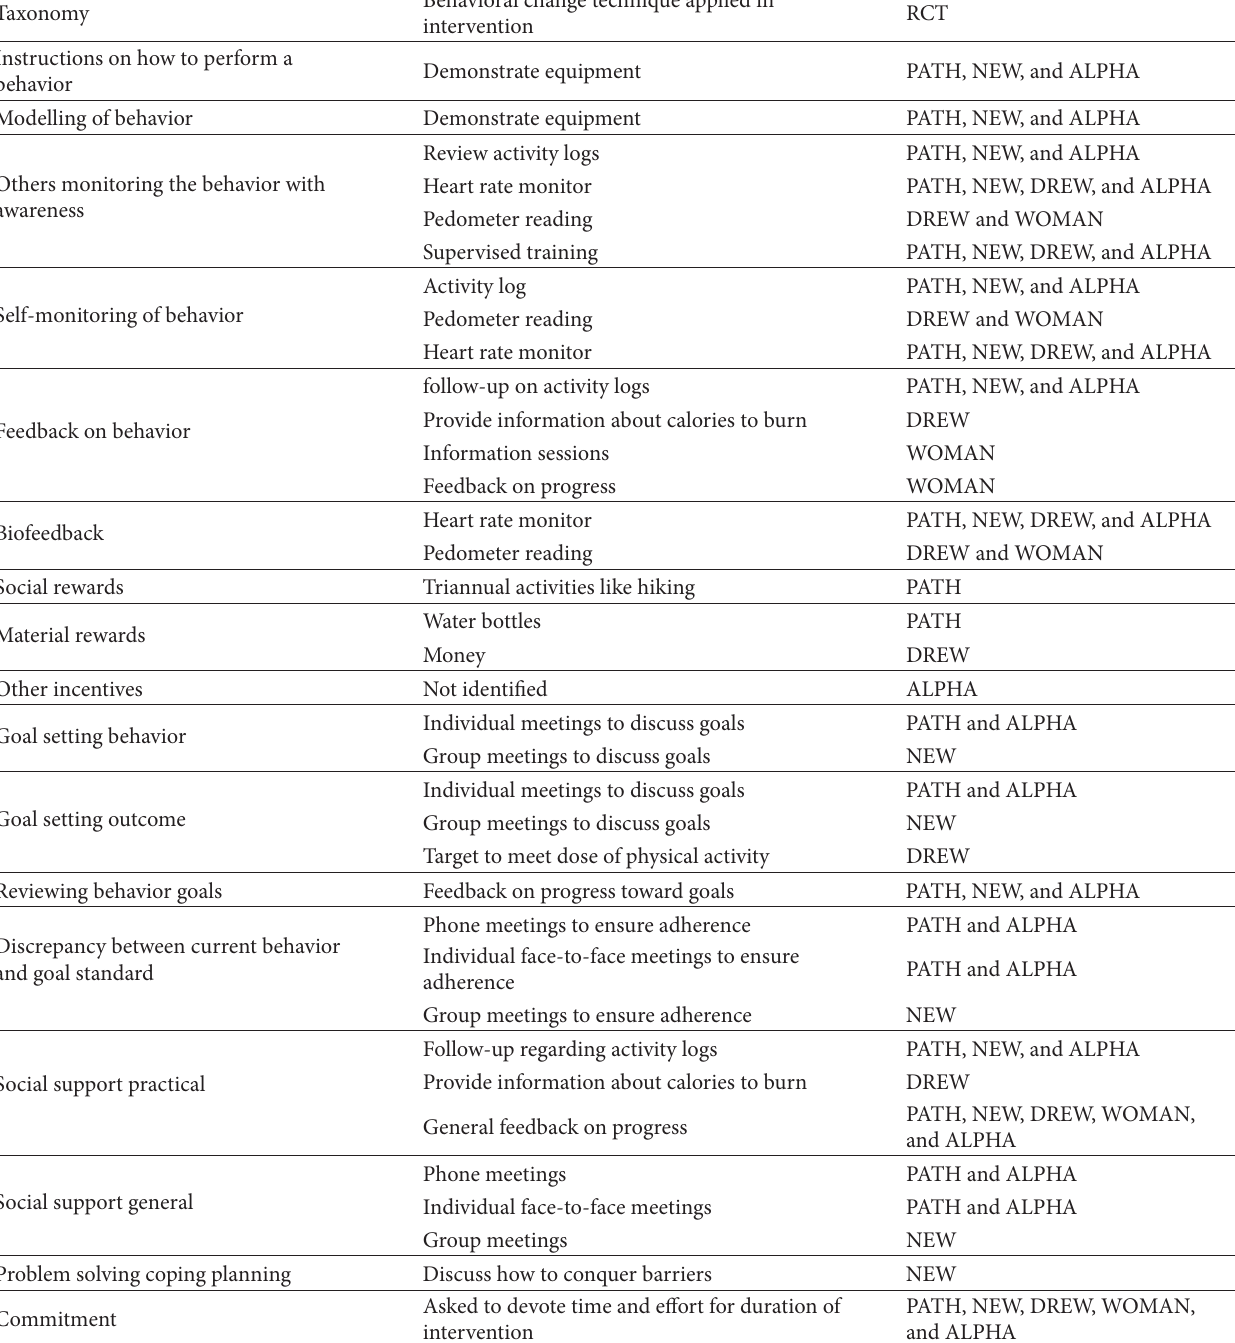
Table 4: The behavior change technique taxonomy applied to the selected randomized controlled